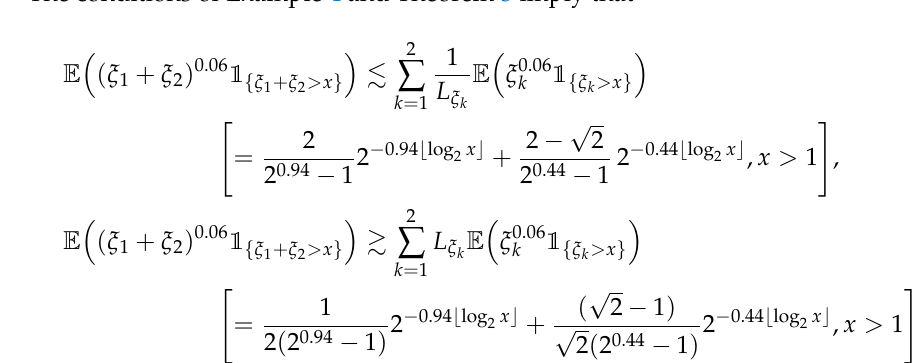
(cid:16) (cid:17) 2 E 1 ∑ ξ 1/2 { ξ k > x } k k = 1